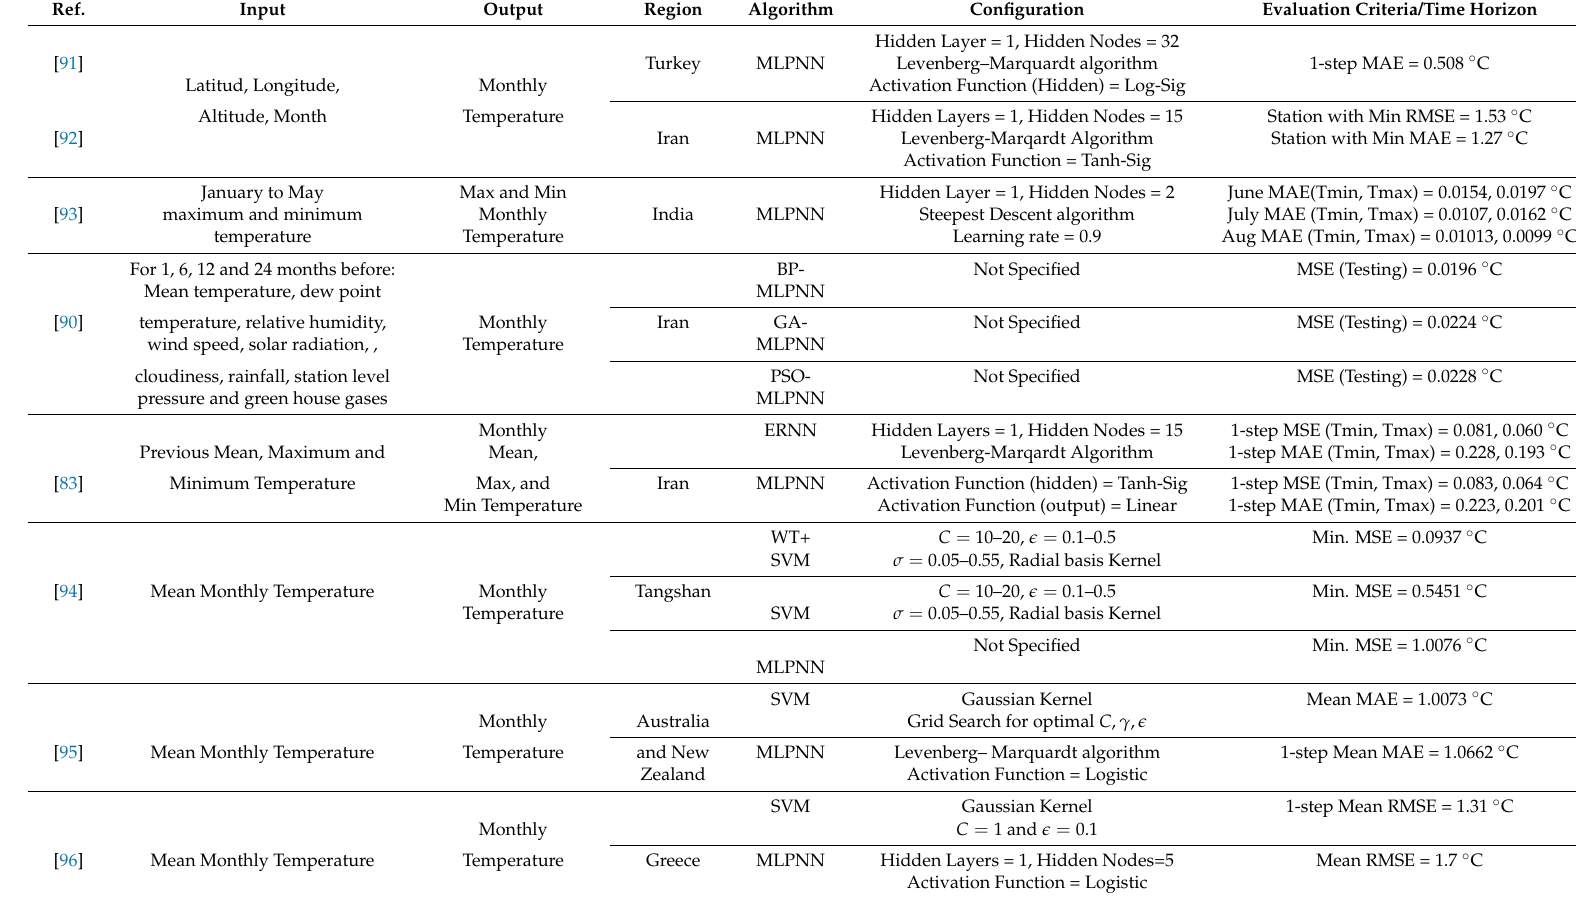
Table 4. Representative papers related to Monthly Temperature